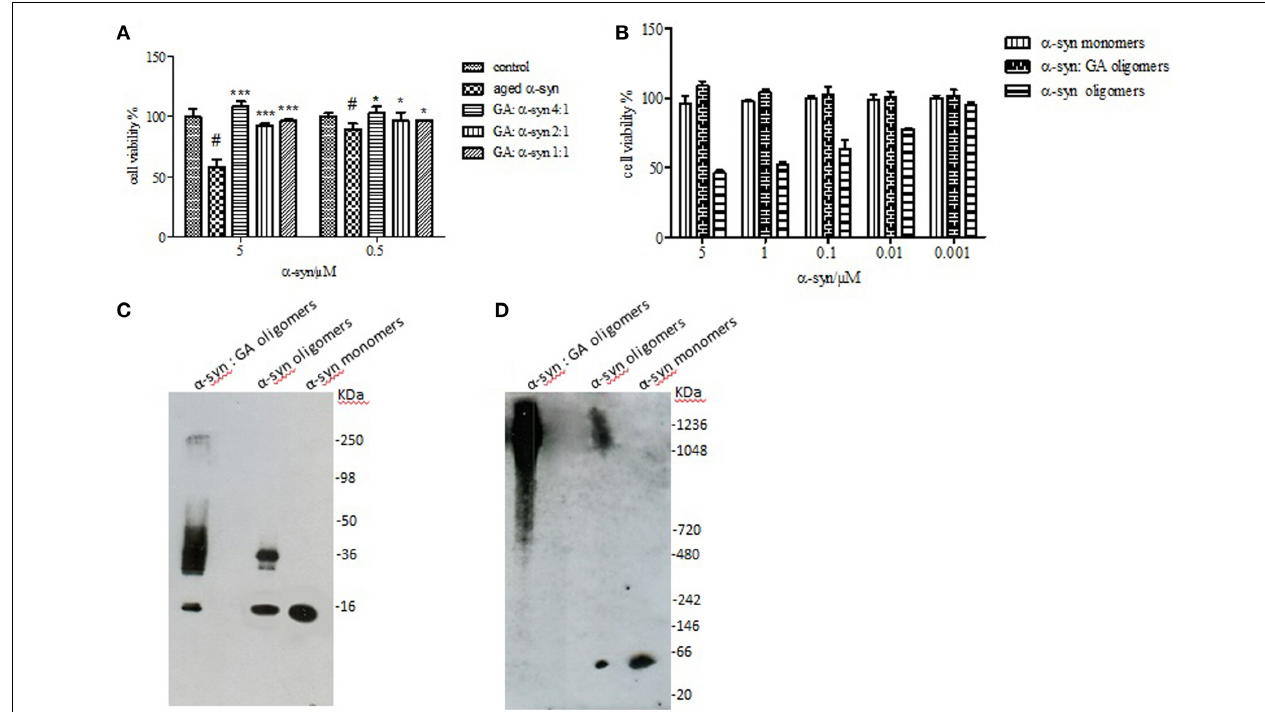
FIGURE 5 | Effect of GA on the toxicity of aggregated α -syn. (A) The viability of BE (2)-M17 human neuroblastoma cells was estimated by the MTT assay. The results are expressed as percentage of the control average (i.e., untreated cells). The cells were treated with aggregated α -syn with/without GA for 48h prior to MTT addition (average of 3 wells ± standard deviation. Statistical analysis was performed using two-tailed unpaired t -test, ∗∗∗ , p < 0 . 001; ∗ , p < 0 . 05). (B) The viability of BE (2)-M17 human neuroblastomacells was estimated by the MTT assay.